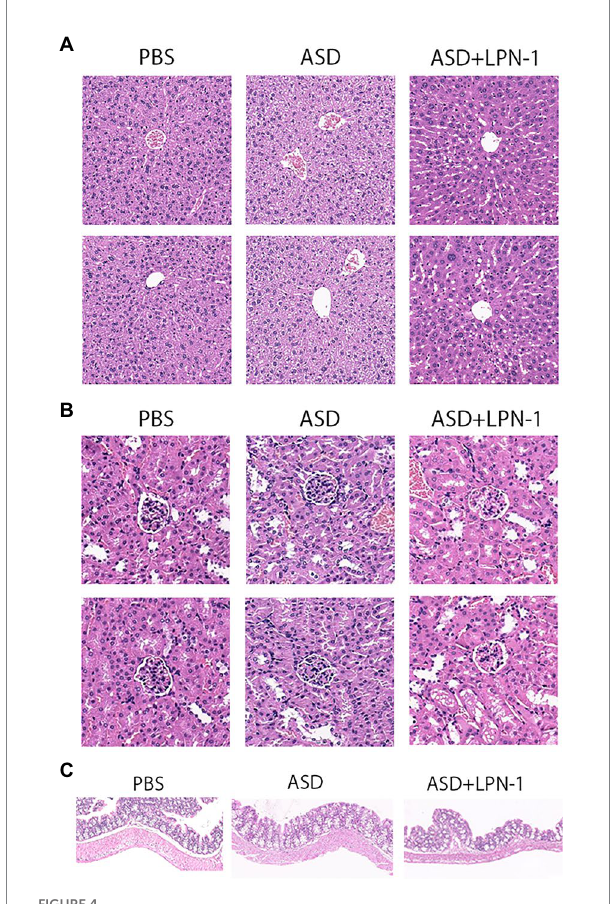
FIGURE 4 H&E staining showing histological cell morphology and inflammatory changes. H&E used to observe liver tissue (A) , the cortex, including glomeruli, and renal interstitium are shown (B) , and sections stained with H&E to assess the mucous membrane appearance of the colon (C)